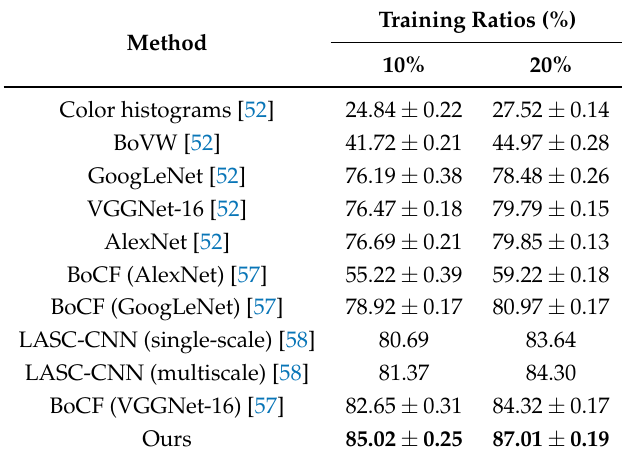
Comparison of classification accuracy with the state-of-the-art methods on the NWPU-RESISC45